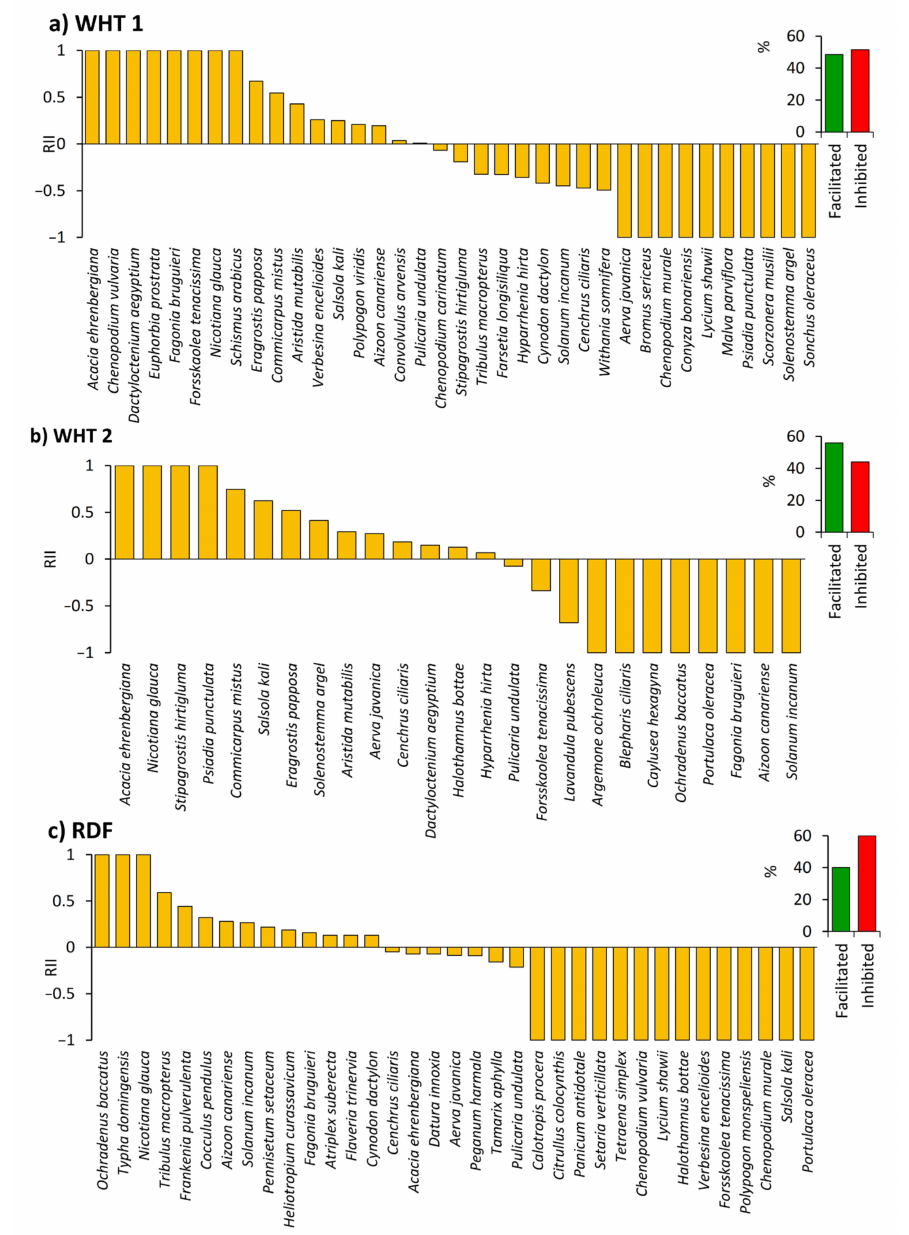
Figure 4. The influence of Nicotiana glauca on the native understory species in Alwaht (WHT) ( a , b ) and Ar Ruddaf (RDF) ( c ) locations, Taif region, western Saudi Arabia. RII: relative interaction index with ranges from − 1 (showing negative effects) to +1 (facilitation). The percentage of facilitated or inhibited species within each location is shown to the right of the